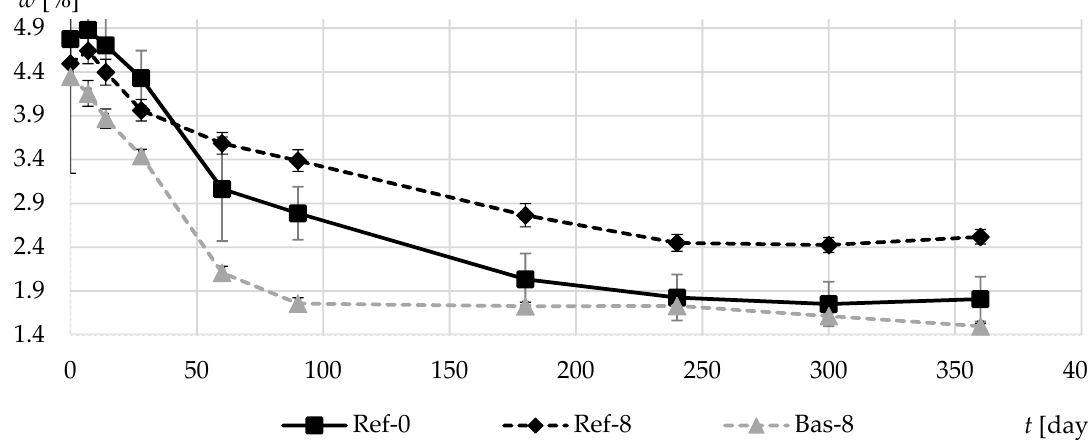
Figure 14. Moisture content of composites in the first 360 days of curing.